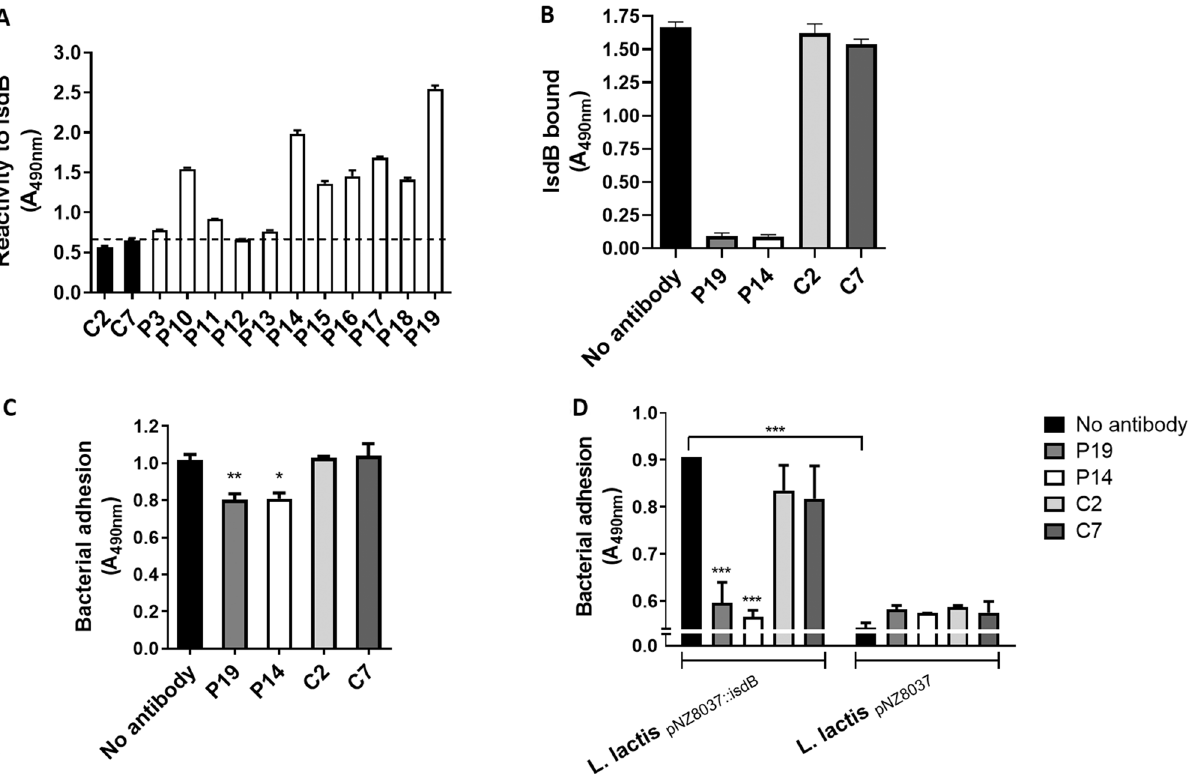
Figure 8. Reactivity of IsdB antibodies from human sera and their effect on IsdB-mediated bacterial adhesion to HUVEC monolayers. (A) Patients’ sera reactivity for IsdB protein. Microtiter wells coated with IsdB NEAT1- NEAT2 were probed with IgG isolated from sera of patients with staphylococcal endocarditis. IgG from healthy donors were used as controls. Bound antibody was detected by the addition of rabbit anti-human HRP- conjugated IgG to the wells. Data are expressed as means ± S.D. of triplicate tests. (B) Effect of IgG isolated from patients’ sera on IsdB NEAT1-NEAT2 binding to HUVEC monolayers. Confluent HUVEC monolayers were treated with calcium ionophore A23187 and incubated with recombinant IsdB NEAT1–NEAT2 in the presence of the indicated IgG isolated from patients’ sera. Bound IsdB NEAT1–NEAT2 was detected by the addition of a rabbit polyclonal IsdB antibody followed by HRP-conjugated goat anti-rabbit IgG. The binding of IsdB NEAT1– NEAT2 to the monolayers in the presence of control IgG is also reported. Binding observed in the absence of antibodies was set as 100% binding. (C) Adhesion of S. aureus SH1000 to HUVEC monolayers in the presence of IgG isolated from patients’ sera. HUVEC cell monolayers treated with ionophore A23187 were incubated with cells of S. aureus SH1000 WT in the presence of the indicated IgG isolated from patients’ sera or healthy human sera. Adhesion was determined by the addition of an HRP-conjugated rabbit anti-mouse IgG. Bacterial attachment observed in the absence of antibodies was set as 100% adhesion. Statistically significant differences are indicated (*, P < 0.05; **, P < 0.01). (D) Adhesion of L. lactis ectopically expressing IsdB to HUVEC monolayers in the presence of IgG isolated from patients’ sera. HUVEC cell monolayers treated with ionophore A23187 were incubated with cells of L. lactis pNZ8037 or L. lactis pNZ8037::isdB in the presence of the indicated IgG isolated from patients’ sera or healthy human donors. Adhesion of bacteria to HUVEC monolayers was detected through rabbit anti- L. lactis IgG followed by an HRP-conjugated goat anti-rabbit IgG. Statistically significant difference is indicated (***, P < 0.001). Bars reported in (B–D) represent means ± SD of triplicate